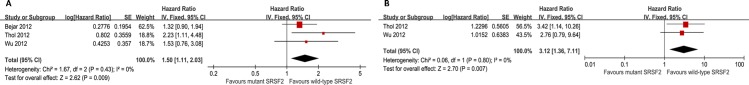
Forest plots of pooled HRs and 95% CIs assessing the prognostic value of SRSF2 mutations in patients with low- or intermediate-1-IPSS risk MDS for: (A) OS and (B) AML transformation.